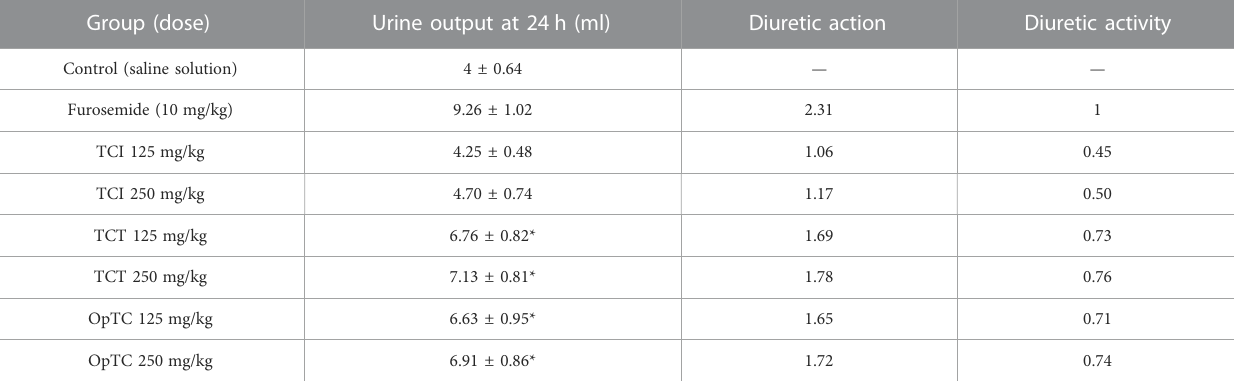
TABLE 2 Parameters of the diuretic effect in saline loaded Wistar rats treated with herbal preparations obtained from Thymus comosus . Values of urine output are expressed as Mean ± SD ( n = 6); (* p < 0.05 vs. saline control). Group (dose) Urine output at 24 h (ml) Diuretic action Control (saline